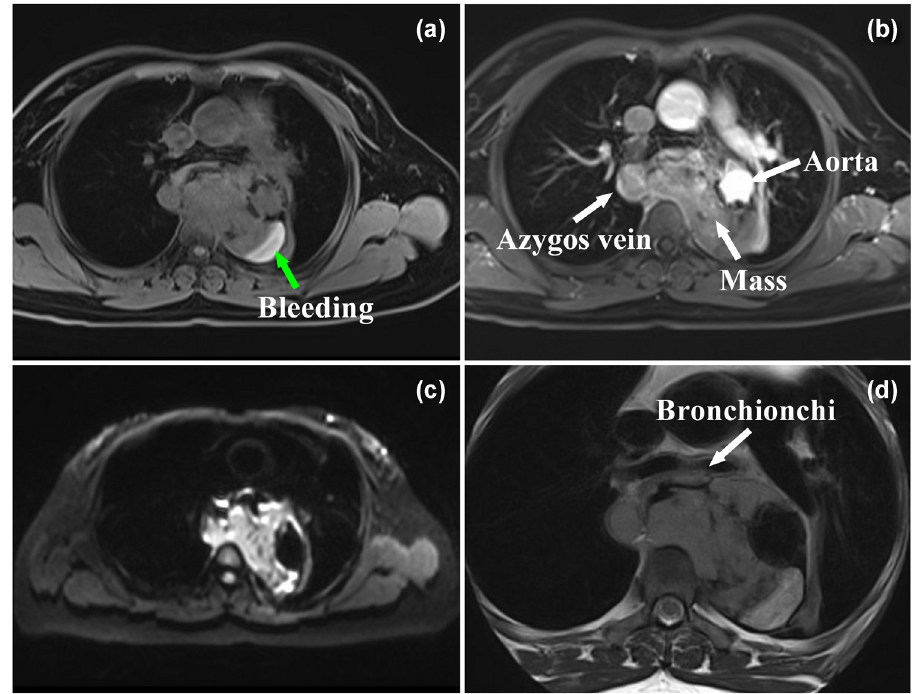
Figure 4: Magnetic resonance imaging showing gradual enlargement of false lumen with mediastinal extensions and a new lesion in the azygos vein. T 1 WI image ( a ) and T 2 WI image ( d ) showing the heterogeneous of “ false lumen ” with bleeding area ( green arrow ) . Contrast - enhanced T 1 WI image ( b ) showing a nonhomogeneous enhancement of the “ false lumen, ” which correspond to the hyperintense regions in DWI ( b = 800 s/mm 2 ) image ( c )